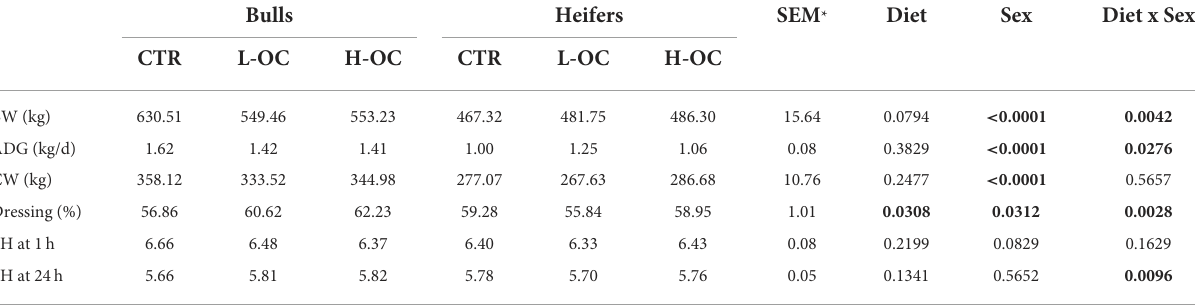
TABLE 2 Means and results of the model for all the measured performance traits: body weight (BW), average daily gain (ADG), carcass weight (CW), dressing, and pH. Bulls Heifers SEM * Diet Sex Diet x Sex CTR